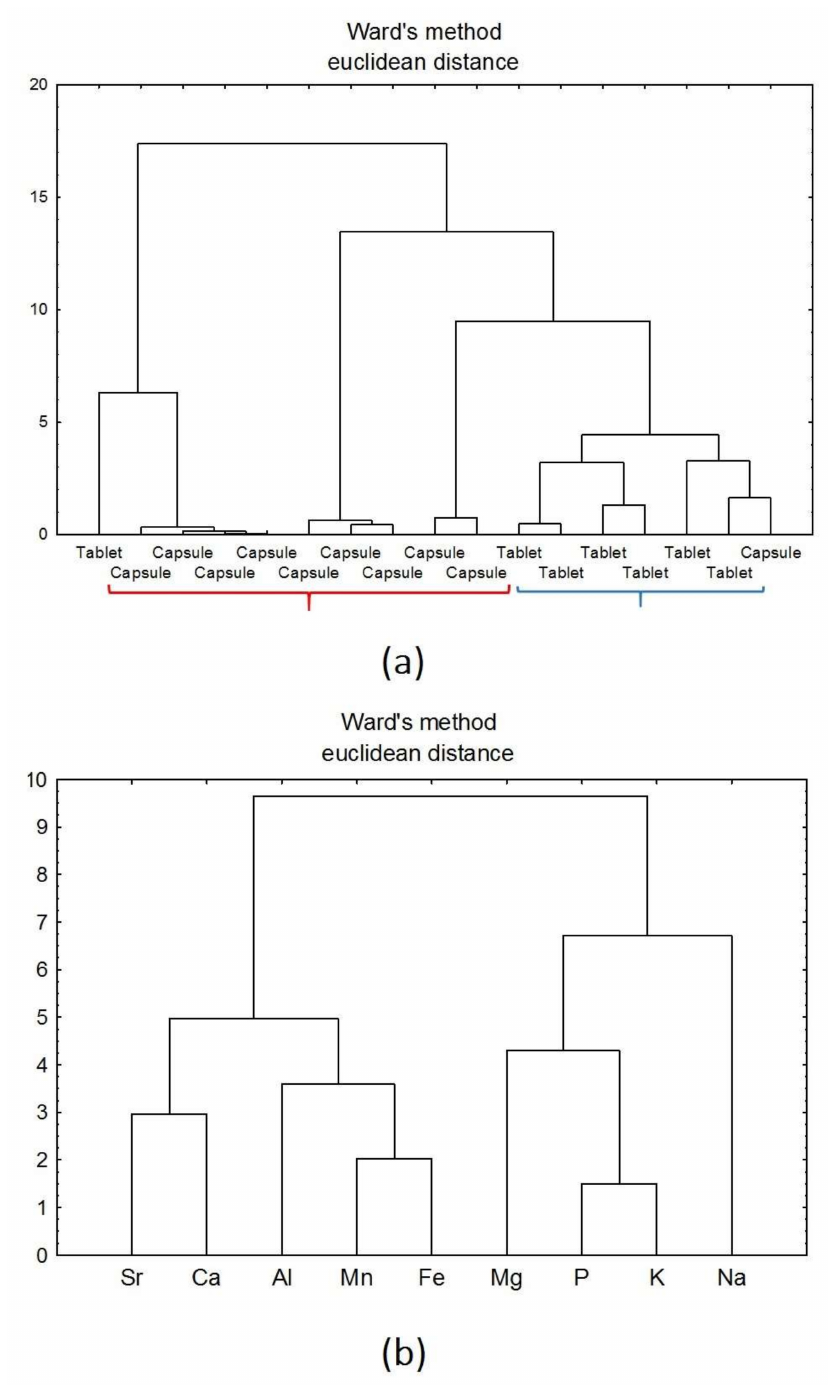
Figure 8. ( a , b ). Hierarchical dendrogram for the forms of dietary supplements (tablets and